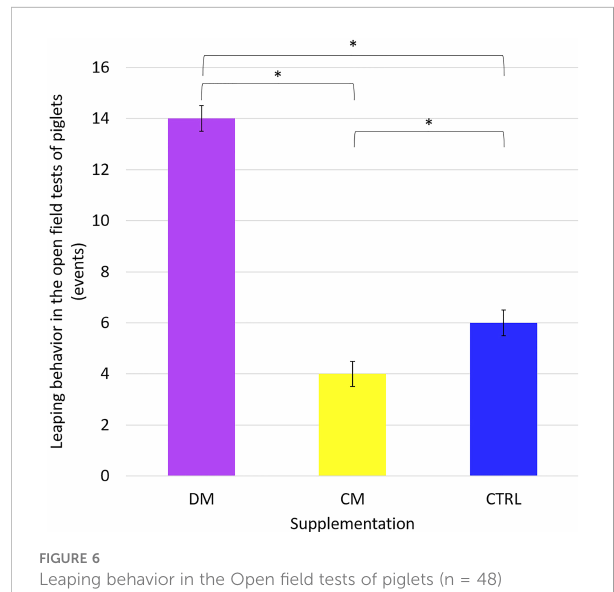
FIGURE 6 Leaping behavior in the Open fi eld tests of piglets (n = 48) supplemented with: DM (Asinine milk), CM (Cow skimmed milk) and CTRL (Control without supplementation) in the phases before and after weaning. Statistical description: (p > 0.05); *(signi fi cant, p < 0.05) by Fisher ’ s